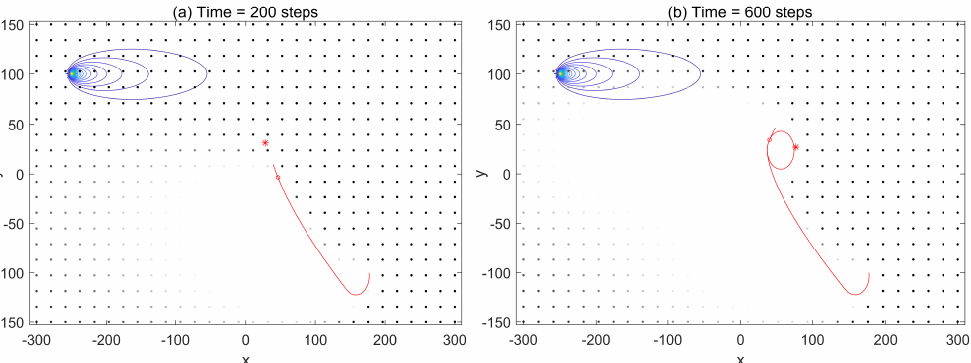
Figure 6. The trajectory (red line), detections (red solid circles), estimated source (red star), and particles (black dots) of the mobile sensor platform using the free energy scheme ( T = 0). The source location at ( − 250,100 ) with the contour plot of the corresponding mean rate.